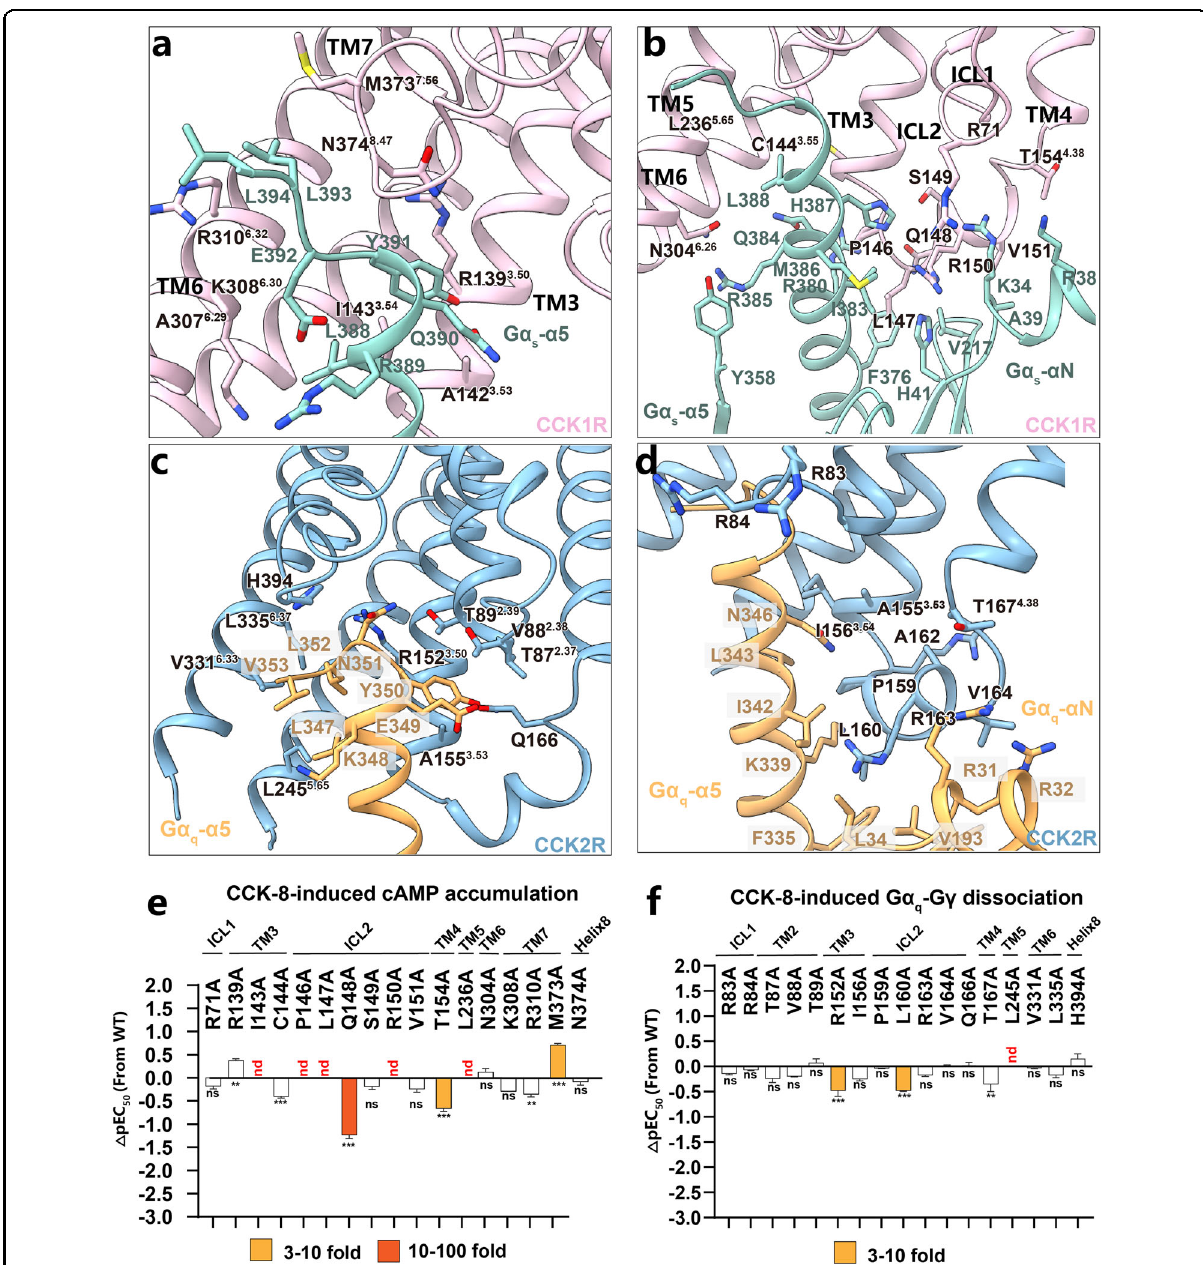
Fig. 6 Structural basis of G protein coupling of CCKRs. a – d Detailed interactions between CCK1R (pink) and the last seven residues of G α s - α 5 helix (cyan) ( a ); between CCK1R (pink) and residues of G α s excluding α 5 helix region (cyan) ( b ); between CCK2R (blue) and the last seven residues of G α q - α 5 helix (orange) ( c ); between CCK2R (blue) and residues of G α α 5 helix region (orange) ( d ). e Mutagenesis analysis of residues in the G α q excluding s - binding site in CCK1R using CCK-8-induced cAMP accumulation assay. f Mutagenesis analysis of residues in the G α q -binding site in CCK2R using CCK- 8-induced G α q – G γ dissociation assay. Bars represent differences in calculated CCK-8 potency (pEC 50 ) for representative mutants relative to WT. Data were colored according to the extent of the effect. ns, no signi fi cance, ** P < 0.001, *** P < 0.0001 (one-way ANOVA followed by Dunnett ’ s post hoc test, compared with the response of WT). nd, pEC 50 change went beyond the detection α N orientation of CCK1R – G complex with other GPCR – G protein complexes. In each is closest to that of s s panel (Supplementary Fig. S5a, f), the complexes were A R – G and β AR – G , whereas the conformation of the 2A s 2 s α 5 helix shows marked differences when compared to that aligned by the receptor, thus showing differences in the orientation of the G in other GPCR – G protein relative to the receptor. The complexes. Owning to the unique s s